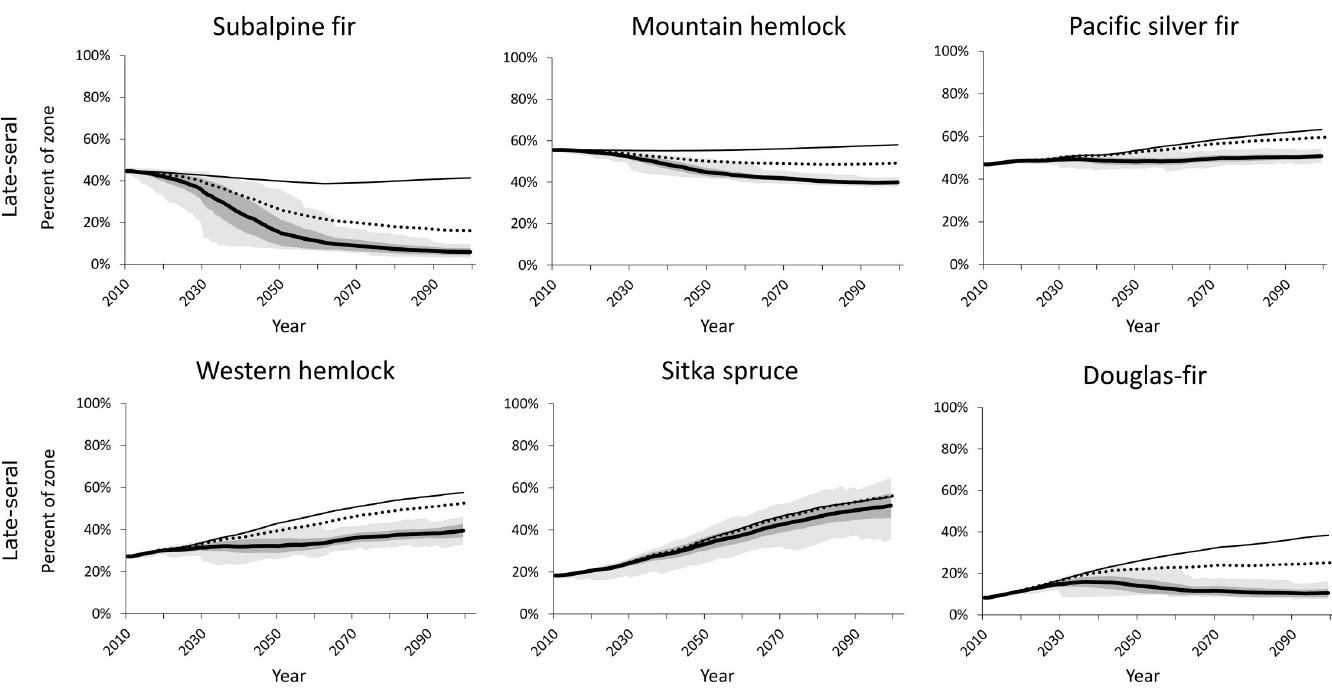
Fig 9. Projected trends and variation in late-seral conditions under difference climate and fire exclusion assumptions. Partial fire exclusion assumes a 50% reduction in area burned. Note y-axes have different scales and some lines have near-complete overlap. See Fig 7 for legend.